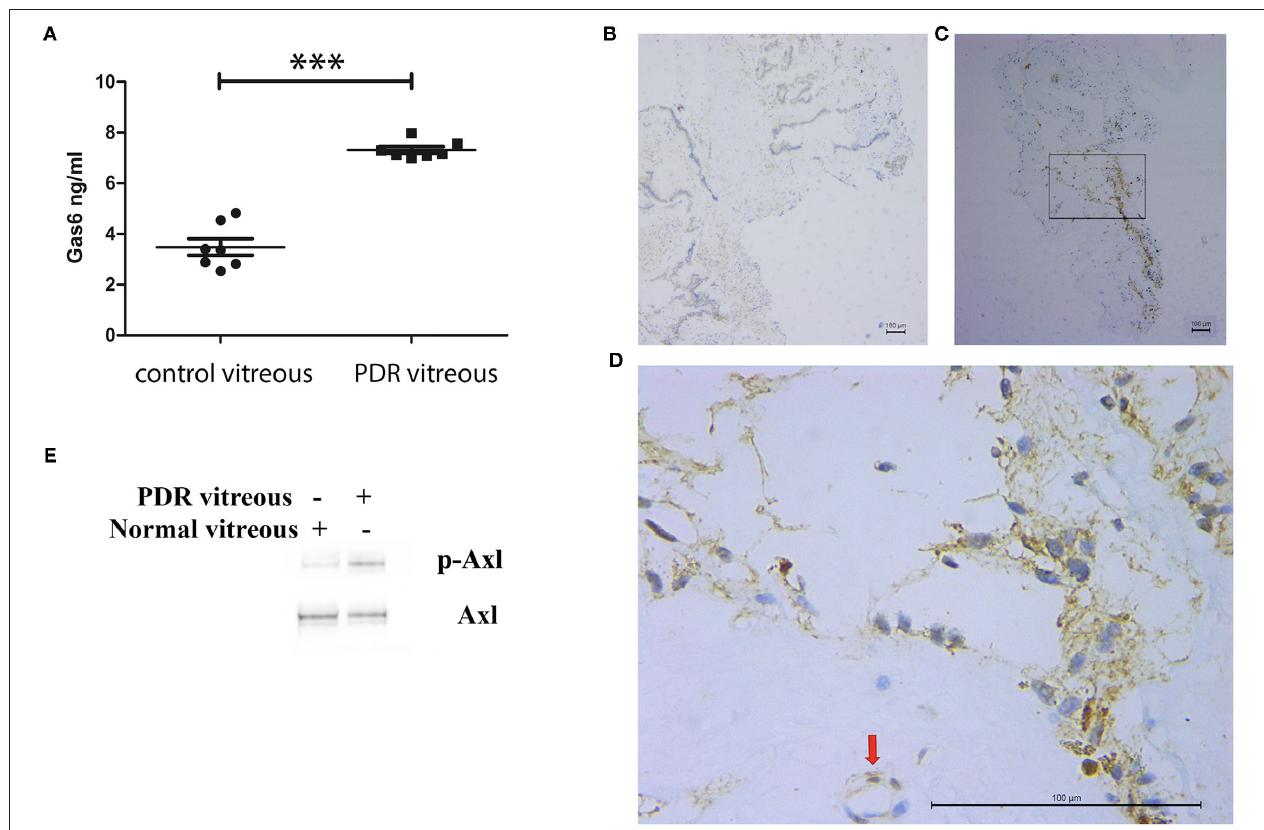
FIGURE 1 | Elevation of growth arrest-specific protein 6 (Gas6), an Axl ligand in vitreous from patients with proliferative diabetic retinopathy (PDR). (A) ELISA analysis of Gas6 in vitreous from patients with or without PDR. (B–D) Immunohistochemistry analysis of p-Axl at fibrovascular membranes from patients with PDR. (B) Immunoglobulin G (IgG) as a negative control; (C) p-Axl; (D) higher magnification from (C) . (E) Western blot analysis of p-Axl in human retinal microvascular endothelial cells (HRECs) stimulated by PDR vitreous. ***means the difference was significant and P <